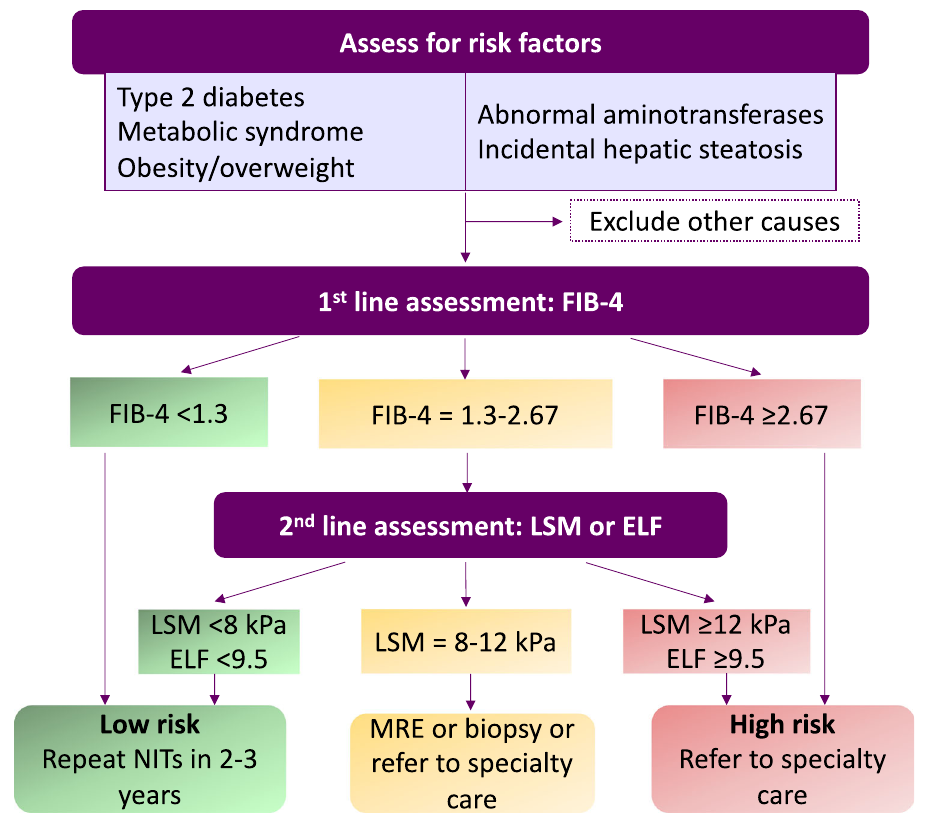
Fig. 2 Sequential risk strati fi cation of patients with hepatic steatosis or metabolic risk factors. The sequential use of NITs aiming at the identi fi cation of patients with advanced liver disease, histologically de fi ned as stages F2 and F3, allows in a fi rst step to rule-out cases with advanced disease using the FIB- 4 score. The presence of metabolic risk factors informs about the at-risk population. This will be crucial to enable the assignation of resources to the group with the highest risk of a detrimental outcome. Patients in the indeterminate category will need to be further evaluated by using a more re fi ned second line test, including LSM or ELF. Patients in the high-risk category should be referred to specialists for further management. Based on the resources and availability of NITs, one-step testing strategies could be used in the future. ELF Enhanced Liver Fibrosis, LSM liver stiffness measurement, MRE magnetic resonance elastography, NIT non-invasive